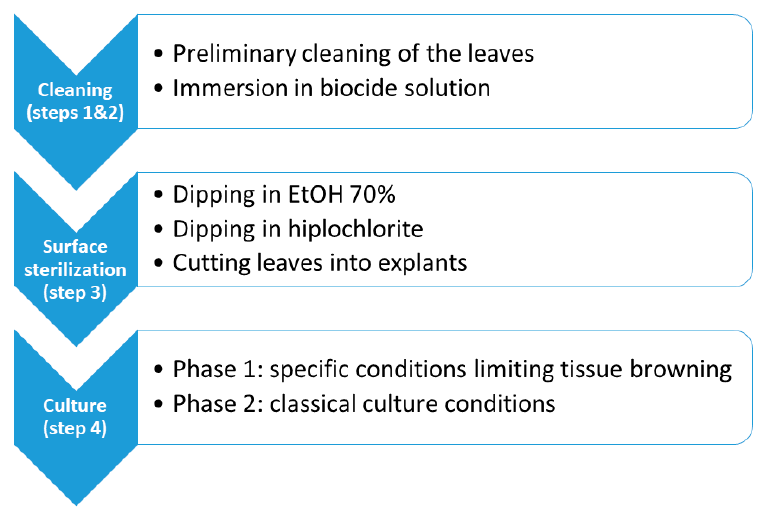
Figure 1. Workflow of a standardized procedure, including surface sterilization from leave samples collected in natura.